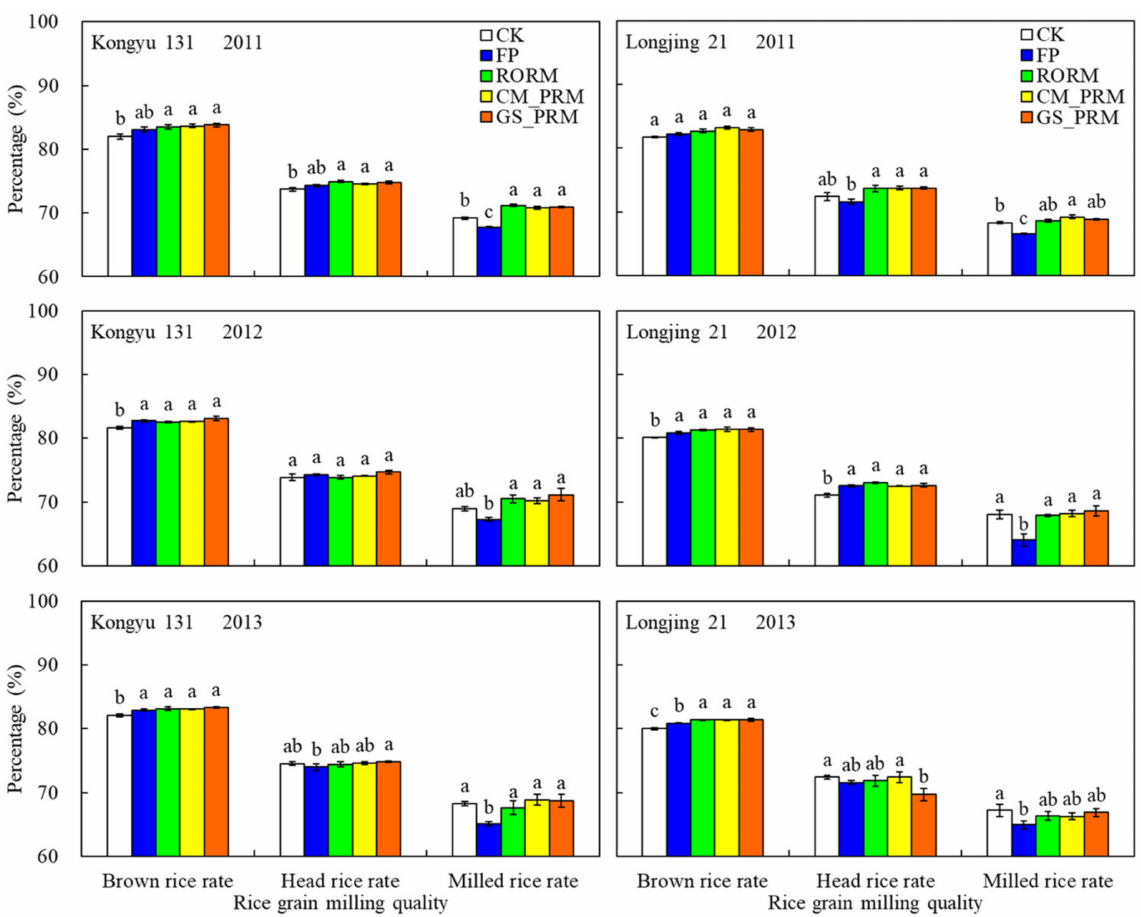
Figure 7. The milling quality of different rice management systems of two rice varieties, Kongyu 131 ( left ) and Longjing 21 ( right ), from 2011–2013. CK, FP, RORM, CM_PRM, and GS_PRM represent check, farmer’s practice, regional optimum rice management, chlorophyll meter-based precision rice management, and GreenSeeker sensor-based precision rice management, respectively. Different letters indicate significant differences at p < 0.05 level in the same year. The error bars indicate standard